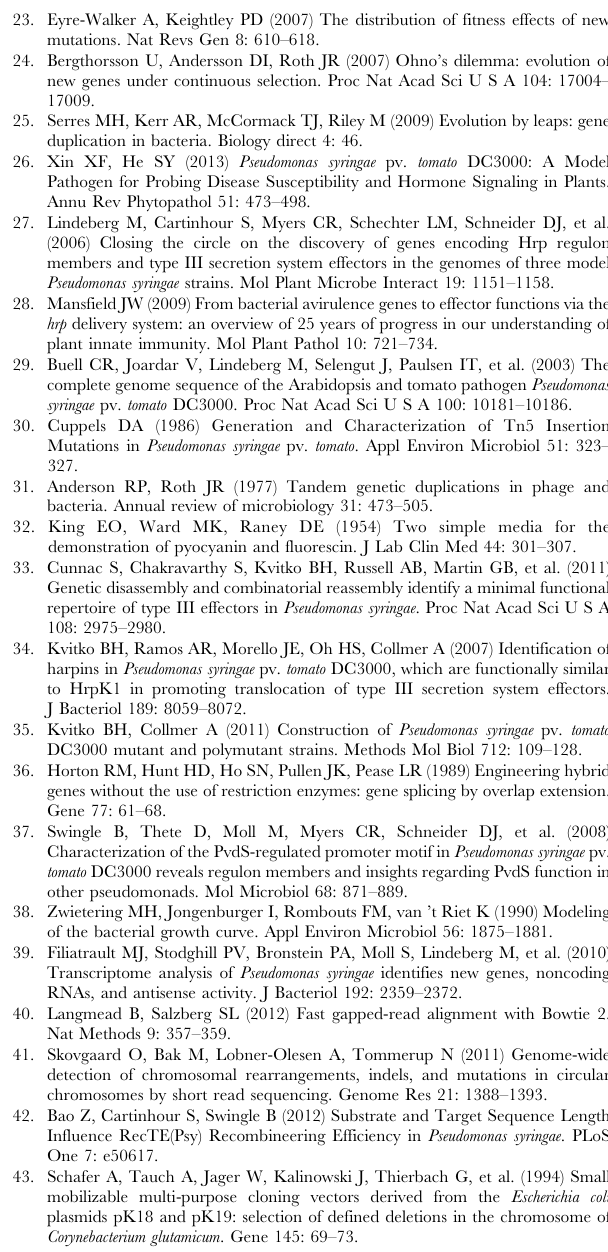
Table S3 Genes and functional role categories con- tained within the 165 kb duplication. Multiple JCVI categories are separated by a ‘‘/’’. In instances where a gene does not have a JCVI category assigned, the primary genbank annotation is shown. Genes annotated as having roles in pathogenesis are indicated with ‘‘ ¤ ’’. Genes in the same functional role category are indicated by the color of background